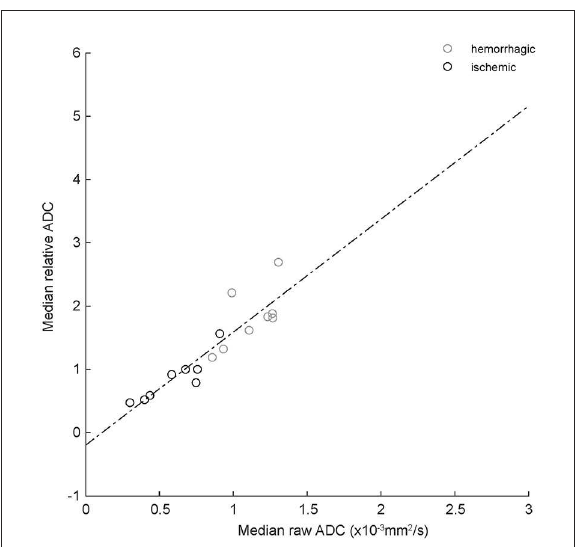
FIGURE3 Correlation between absolute and relative median ADC values for ischemic (black circles) and hemorrhagic (gray circles) CVAs. The dashed line is best-fit linear regression (equation in text). R 2 = 0.82, indicating good correlation.